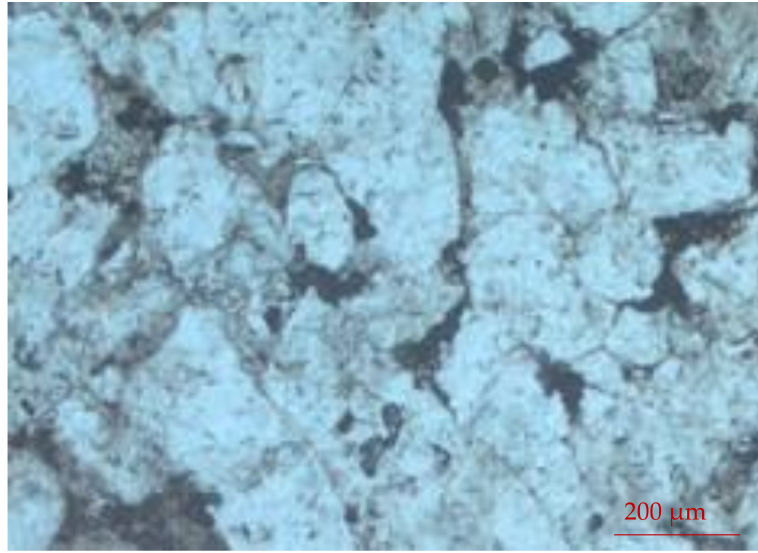
Figure 3. Diagram of the internal conditions of the core.